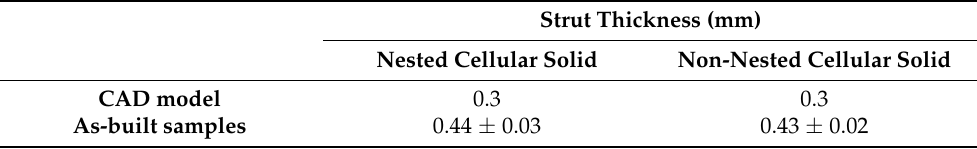
Table 1. Comparison of strut thickness for the CAD model and as-built samples.